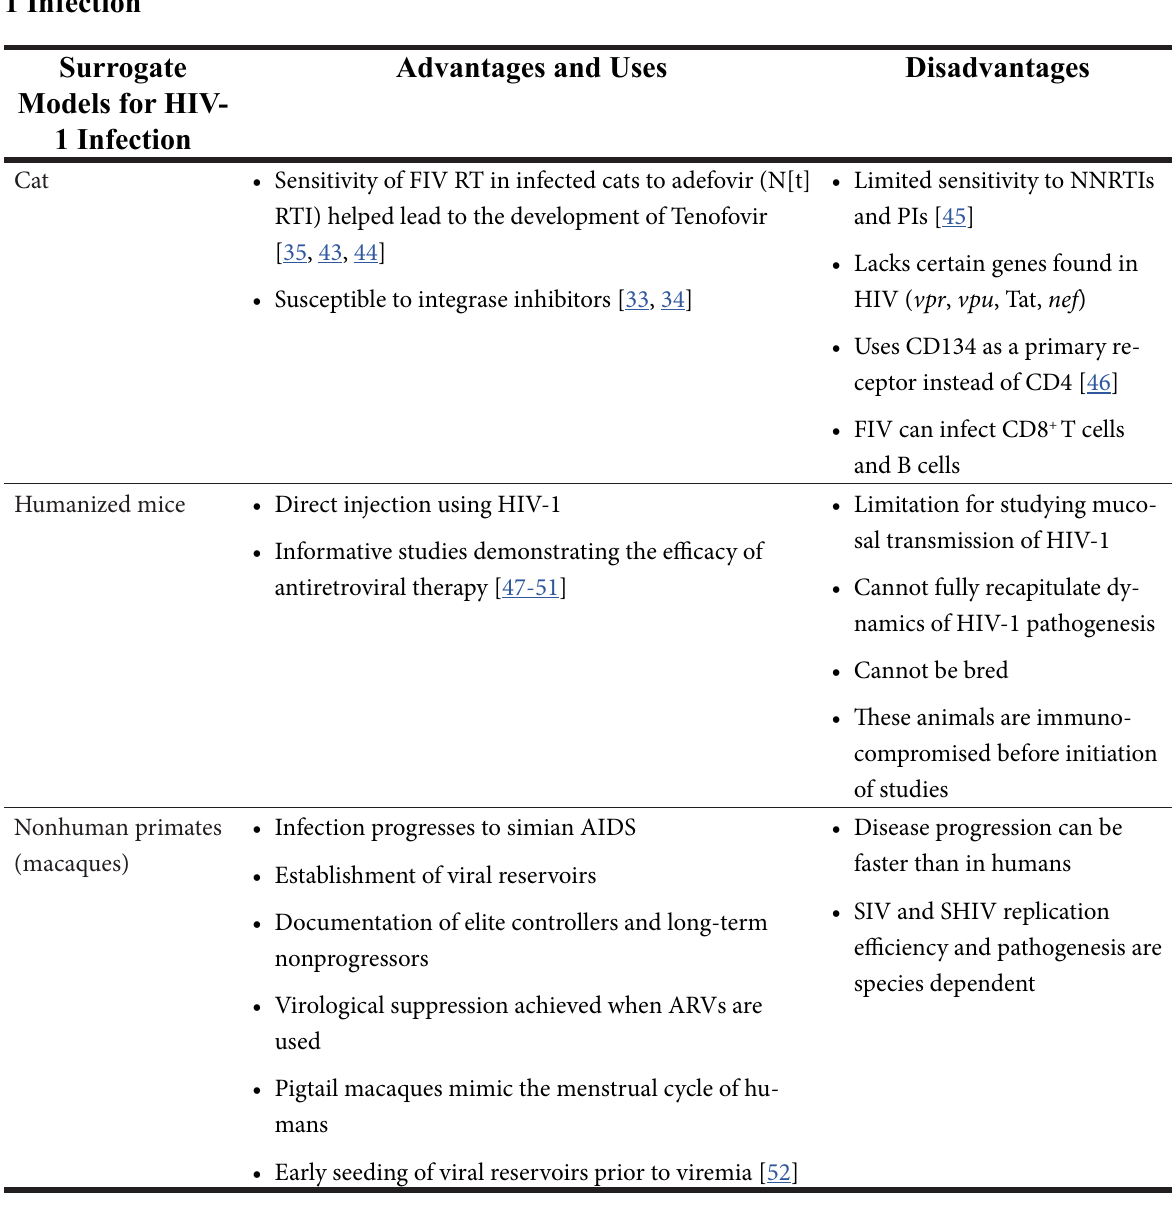
Table 1. Advantages and disadvantages of surrogate models and challenge viruses for HIV- 1